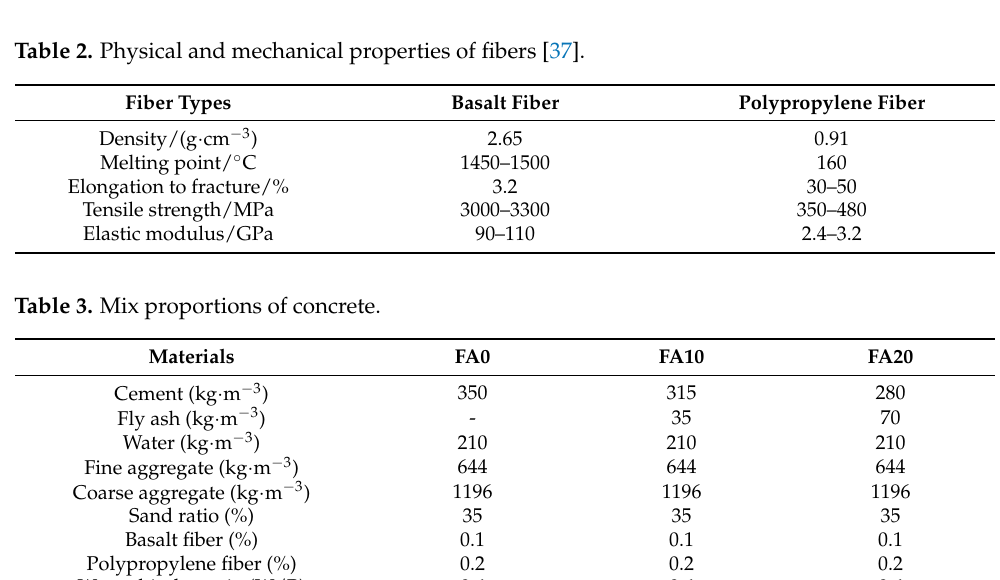
Table 3. Mix proportions of concrete.